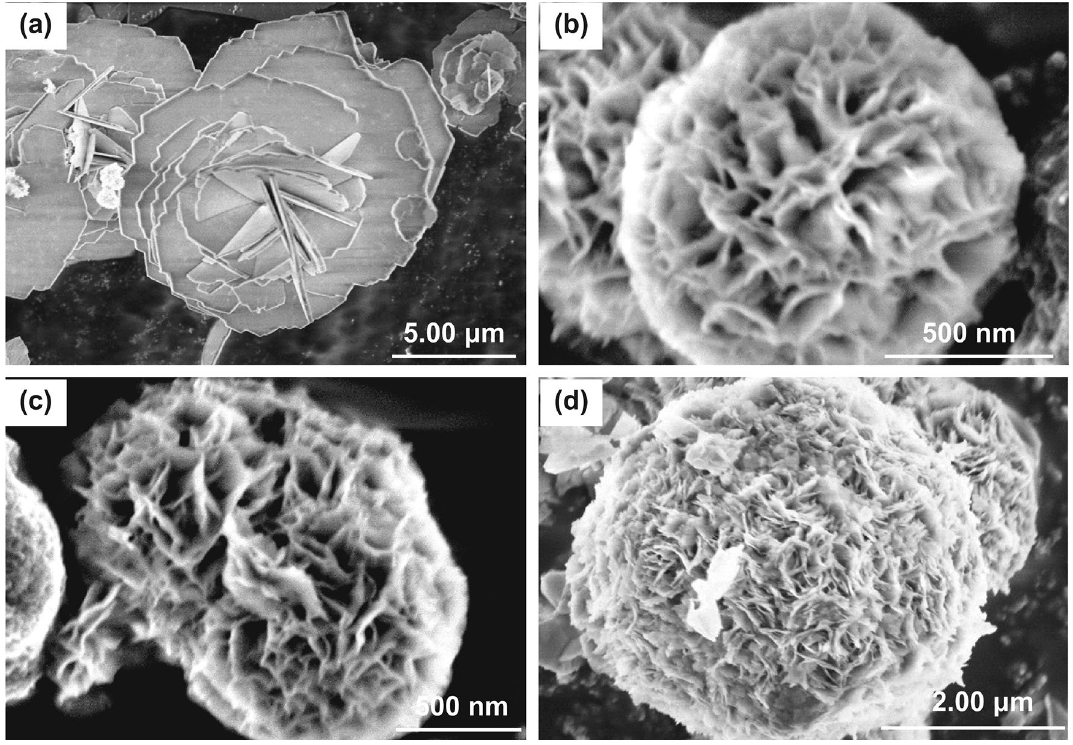
Fig. 3 FESEM image of NiCo 2 O 4 samples using water: ethanol ratios a 1:0, b 3:1, c 1:1, and d 1:3. Reproduced with permission from Ref. [109]. Copyright © 2017 Elsevier